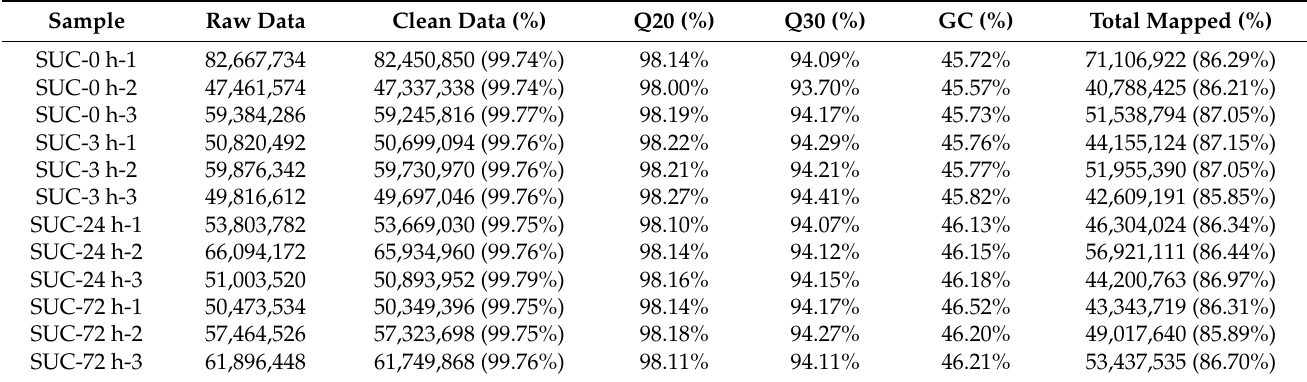
Table 1. Overview of the transcriptome data and quality control of pear peel subjected to sucrose treatment at different time points.